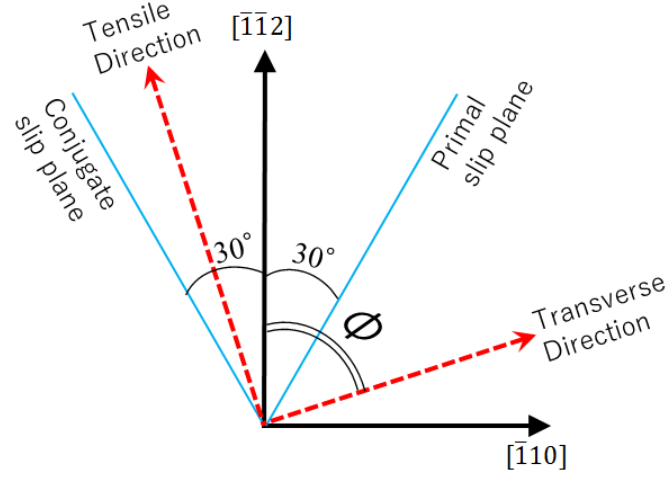
Figure 2. Two slip systems with definition of crystal orientation [21].